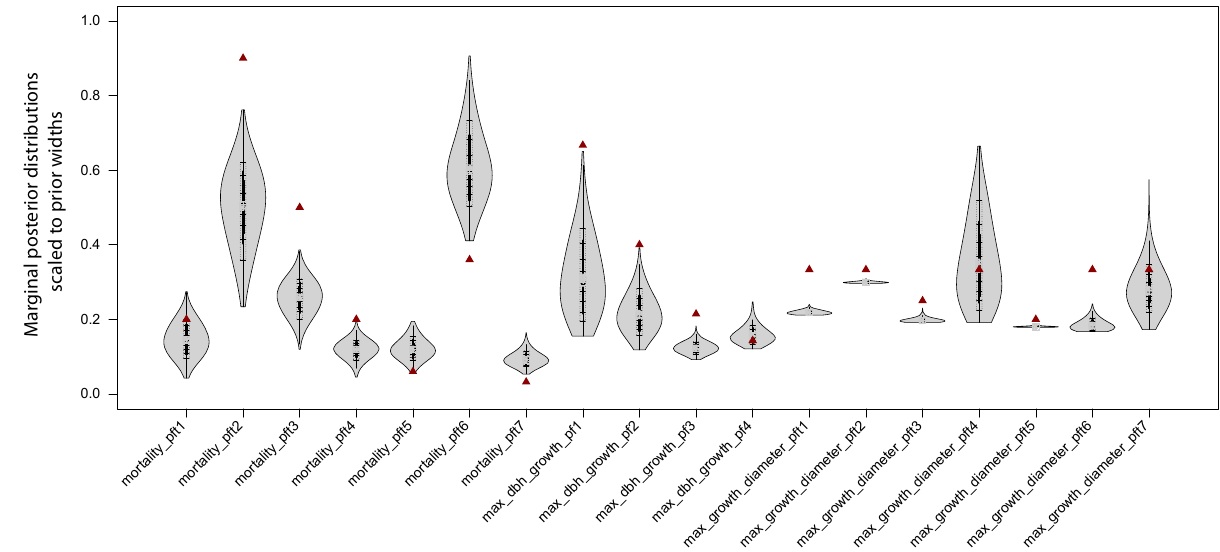
Fig. 5. Marginal posterior probabilities for the model parameters after fitting the model to field data from Ecuador, scaled relative to the uniform prior distributions (see Table 3 in the Supplement for prior values and units). Values used by Dislich et al. (2009) are marked as dark-red triangles. An unscaled version of these distributions and correlations are provided in Figs. 12 and 13 of the